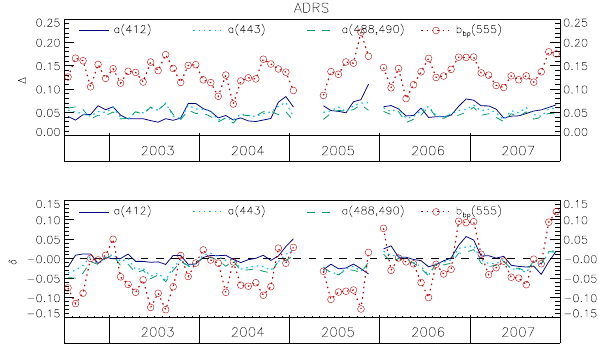
Fig. 7. Same as Fig. 6 for a ph (443) and a cdm (443). The series of 1 for the absorption terms a are mostly in the interval 0.035–0.06, with some time dependence. For instance, the 1 values appear higher in winter for a